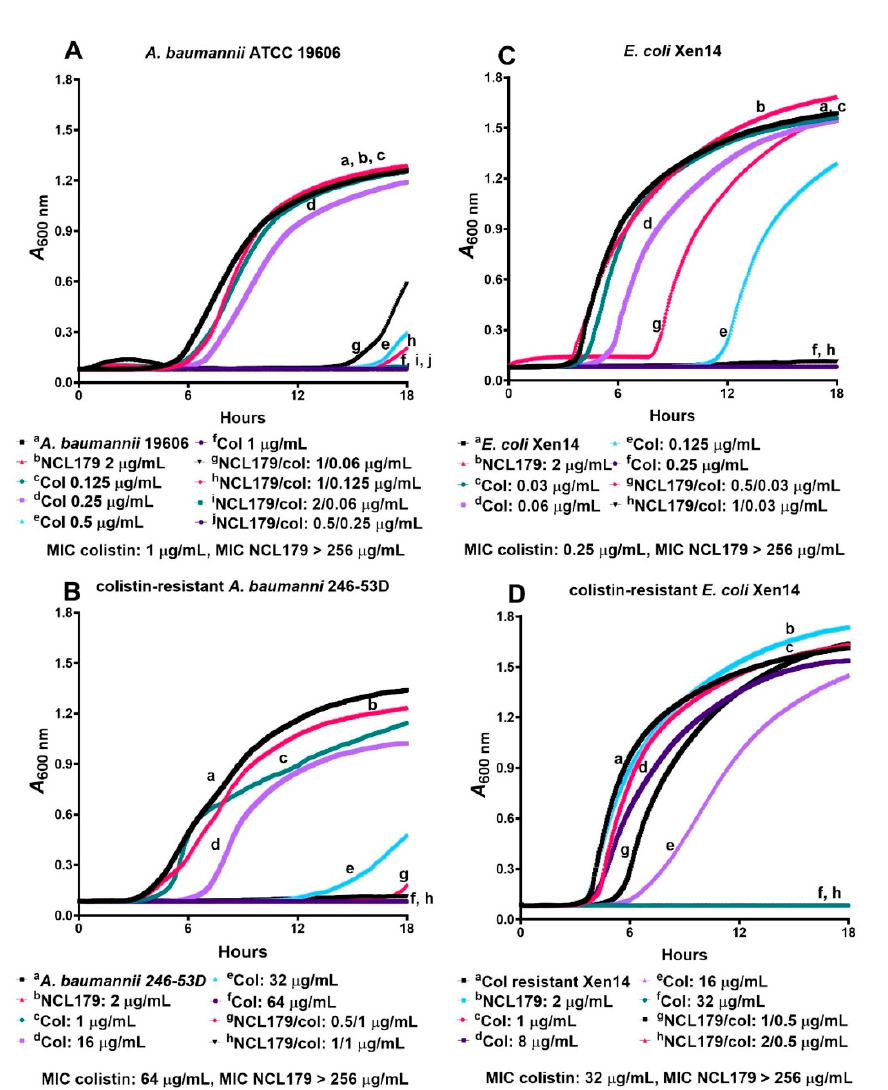
Figure 3. Time-and-concentration-dependent kill kinetics of NCL179 alone and in combination with colistin against Gram-negative bacteria. ( A ), NCL179 alone or in combination with colistin against A. baumannii ATCC 19606; ( B ), clinical colistin-resistant A. baumannii 246-53D; ( C ), E. coli Xen14; and ( D ), colistin-resistant E. coli Xen14. The concentrations of NCL179 and colistin for each combination were chosen based on data presented in Table 2. Assays were performed on a Cytation 5 Multi-Mode Reader (BioTek, Winooski, VT, USA) by optical density ( A 600 nm ) measurements; Col, colistin. 3.3. Combination of NCL179 and Colistin Shows Limited Cytotoxicity to Mammalian Cell Lines The effects of various concentrations of NCL179 alone or in combination with 0.5 µ g/mL colistin to Hep G2 (liver) and HEK293 (kidney) cell lines were examined in an in vitro cell toxicity assay. The results indicate an IC 50 value of 16 µ g/mL for NCL179 at the concentrations tested. In addition, the presence of colistin in the combination did not alter the IC 50 value (Figure 4). The hemolytic titer (HC 50 ) for NCL179 was 32 µ g/mL to human RBCs, whereas the HC 50 for ampicillin was >128 µ g/mL (the highest concentration